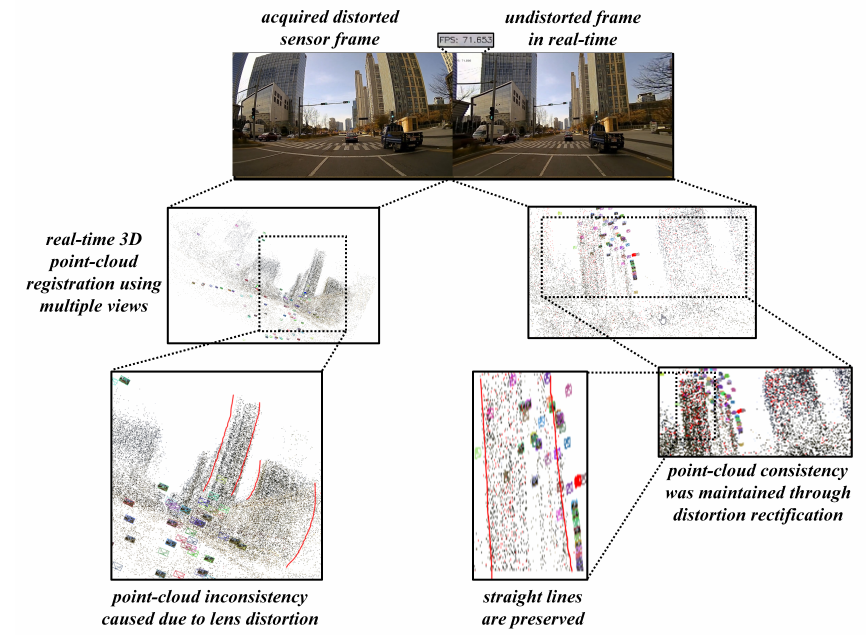
Figure 21. Real-time 3D point-cloud consistency testing on super-wide-angle undistorted